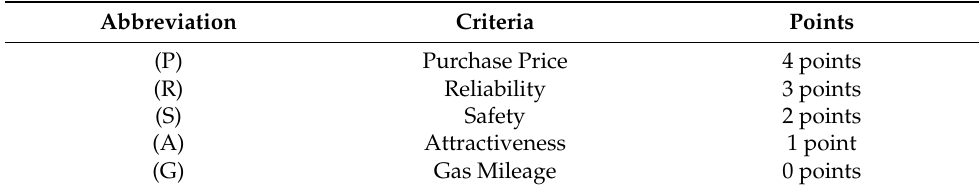
Table 8. Point calculation for pairwise